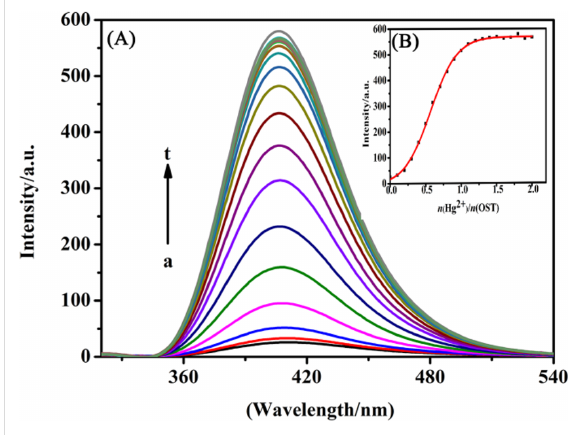
Figure 3: Fluorescence spectra of OST ( c = 3 × 10 − 5 mol ∙ L − 1 ) in H 2 O/CH 3 OH 97:3, v/v in the presence of an increasing concentration of Hg 2+ ions ( λ ex = 325 nm). (A) n (Hg 2+ )/ n (OST) = 0, 0.1, 0.2, 0.3, 0.4,